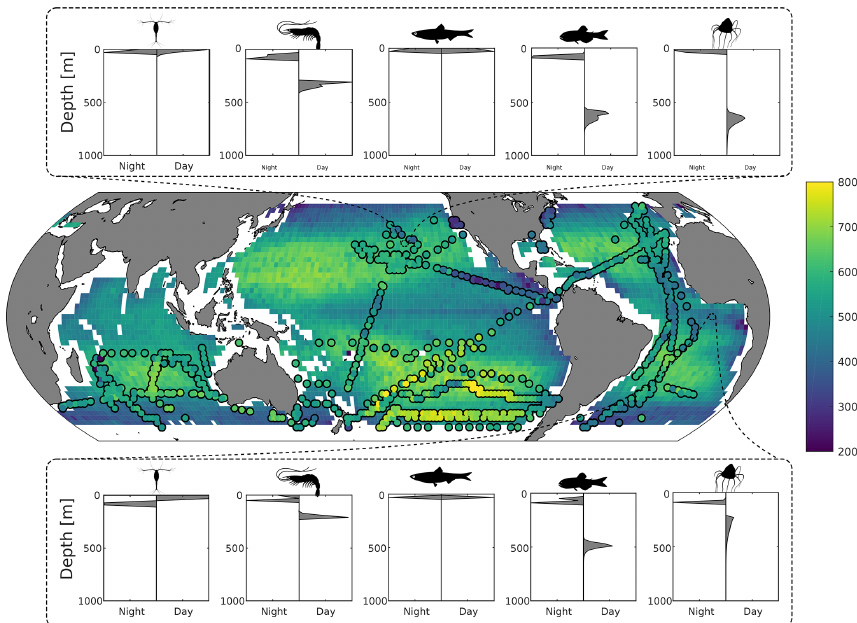
Figure 2. Top and bottom panels: predicted day and night depth distribution of mesozooplankton, macrozooplankton, forage fish, mesopelagic fish, and jellyfish at 26 ◦ N, 152 ◦ W and 7 ◦ S, 0 ◦ E respectively. Middle panel: predicted fish mean depth (in metres) during the daytime, weighted by biomass. Circles overlaid are the observed mean depths weighted by echo intensity recorded using 38kHz echo sounders (Klevjer et al., 2016; IMOS, 2021; Polar Data Centre British Antarctic Survey,